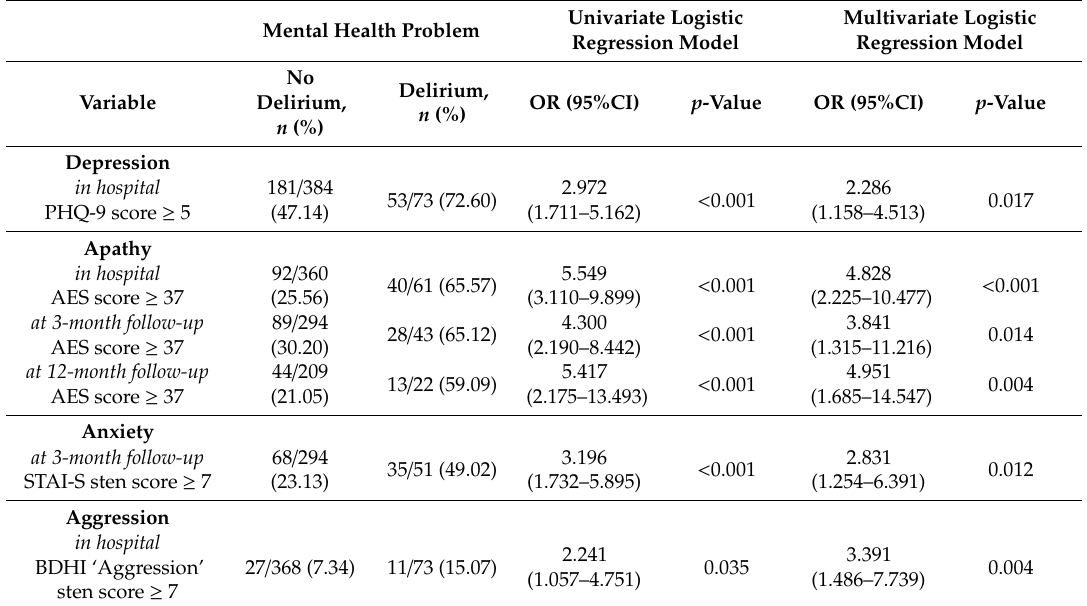
Table 2. Influence of post-stroke delirium on mental health problems during the follow-up period in univariate and multivariate logistic regression